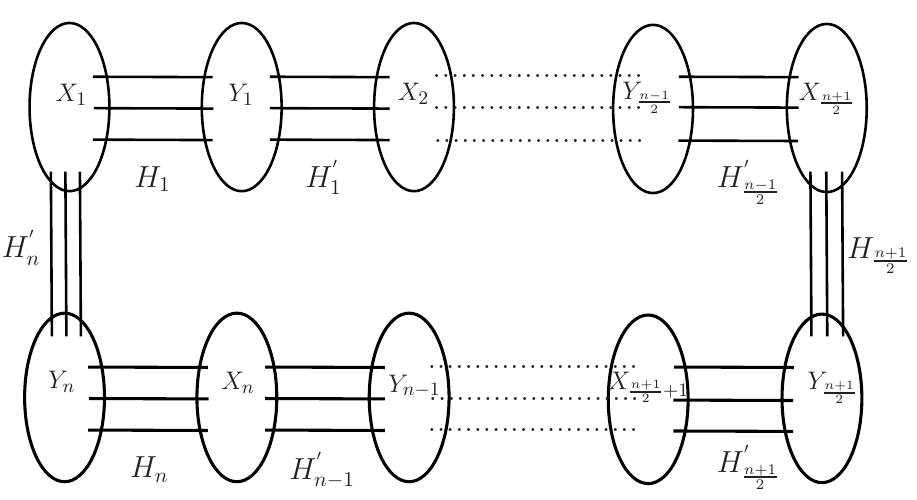
C n when G is bipartite and n is odd. ×